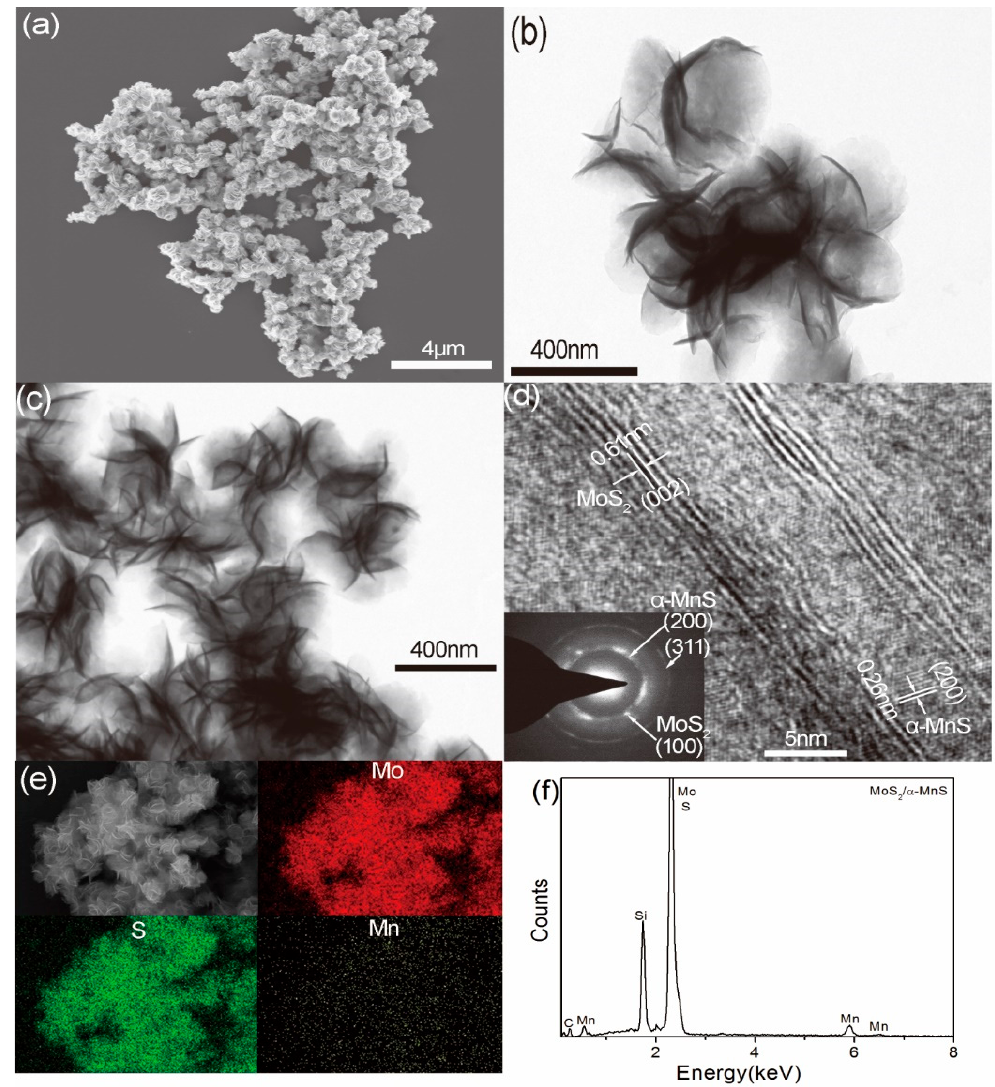
Figure 2. ( a ) SEM; ( b ) and ( c ) TEM at different magnifications; ( d ) HRTEM; ( e ) EDS mapping for elements of Mn, S, and Mo; ( f ) EDS spectrum of hierarchical MoS 2 / α -MnS